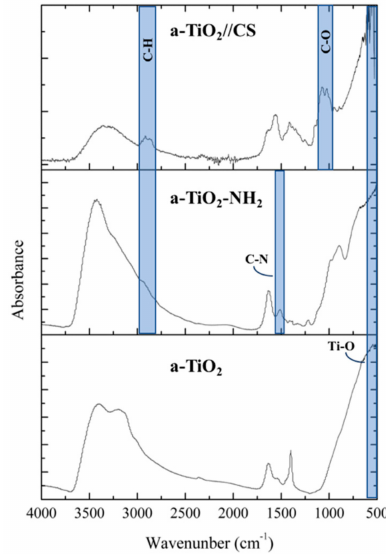
Figure 4. Fourier transform infrared spectroscopy (FTIR) spectra of a-TiO 2 -based NPs.